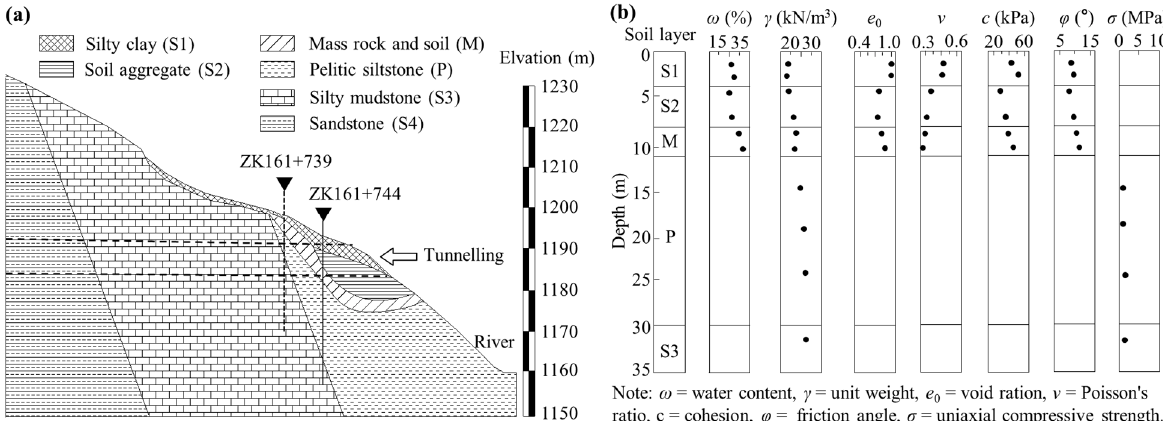
Figure 2. Geological conditions. ( a ) Strata at the collapsed site; ( b ) measured soil parameter profiles.